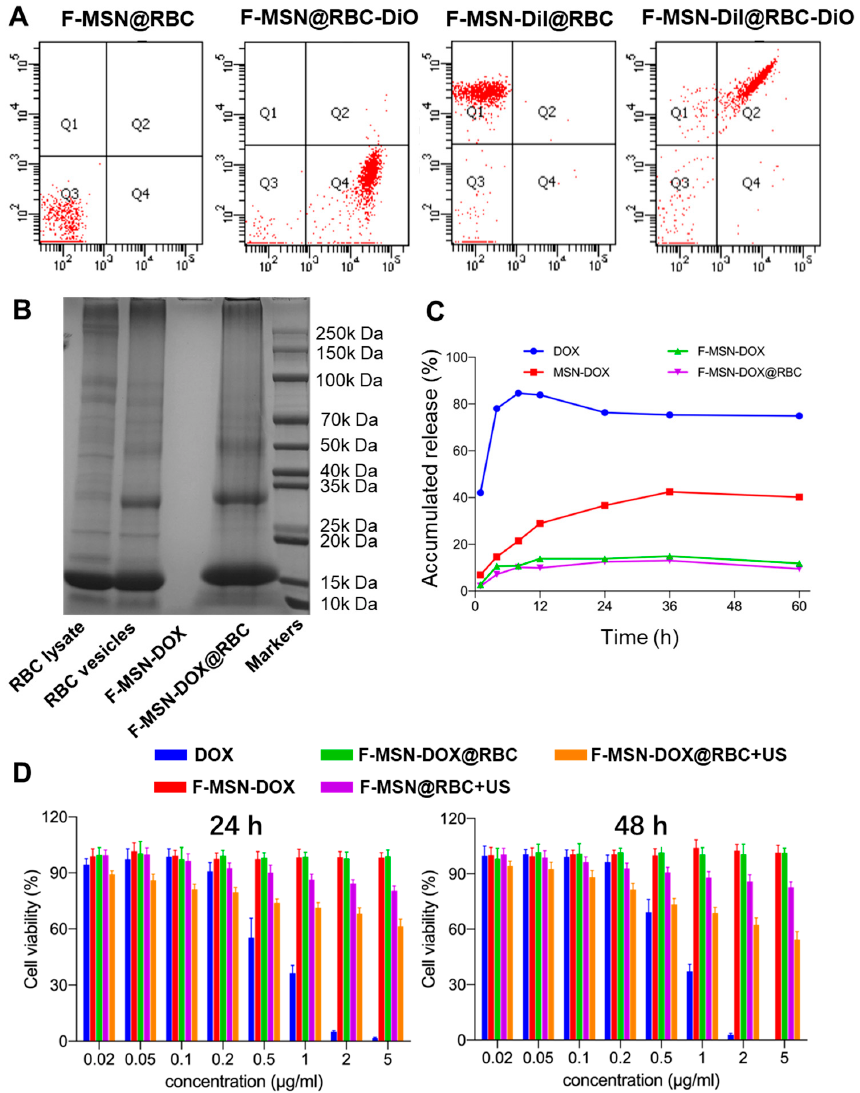
Figure 3. ( A ) The encapsulation of F-MSNs by erythrocyte membrane vesicles assessed by flow cytometry. ( B ) SDS-PAGE of NPs and RBC lysate and RBC vesicles. ( C ) In vitro DOX release profiles of different NPs. ( D ) The viability of RM-1 cells in various groups at 24 and 48 h measured with the CCK-8